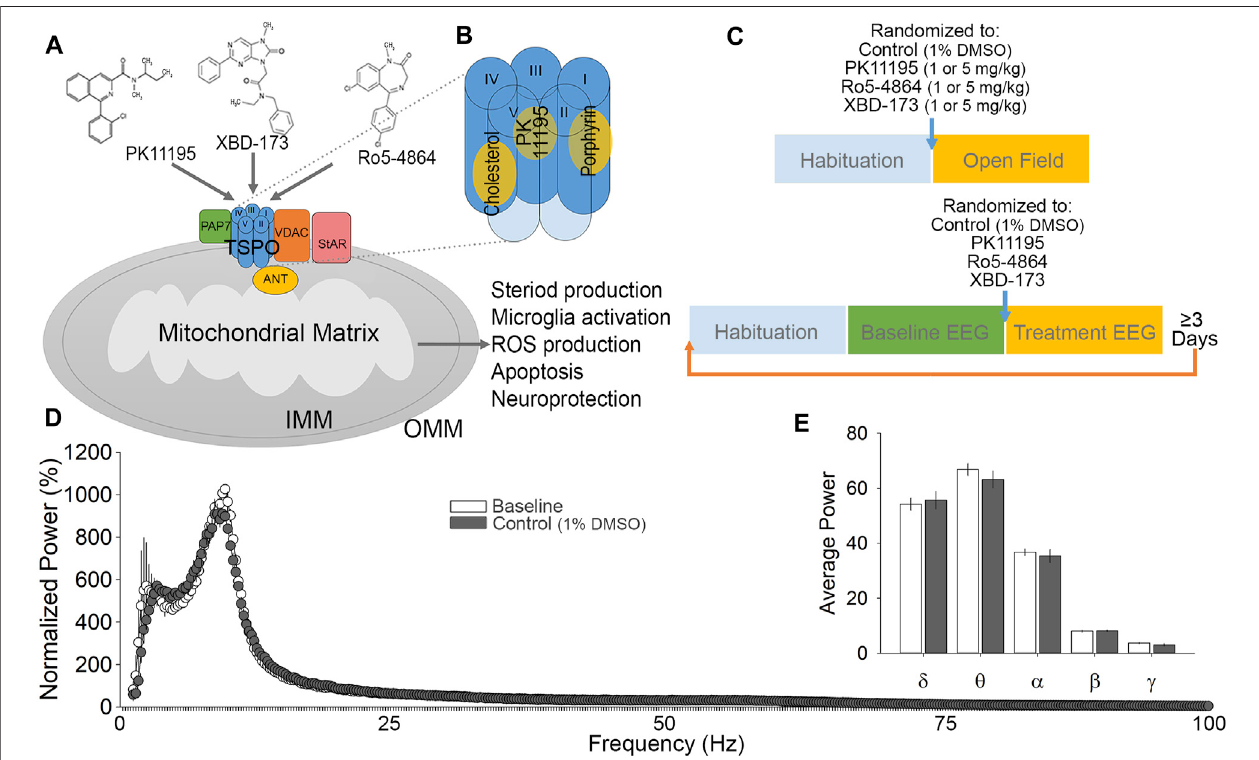
FIGURE 1 | Ligand considerations, experimental design and validation. (A) A diagram of TSPO and associated proteins in the outer mitochondrial membrane. TSPO consists of fi ve transmembrane helices and is associated with voltage-dependent anion channel (VDAC), adenine nucleotide transporter (ANT) and TSPO associatedprotein -7(PAP7). Binding ofPK11195, XBD-173, and Ro5-4864 toTSPOhavebeen demonstratedtoalter multiple cellular functions, primarilywithregards to endocrine signaling and in fl ammation. (B) Proposed binding pockets for TSPO ligands. (C) Experimental timeline for open fi eld test (top) and EEG (bottom) experimentalprotocols.Eachblockrepresents1 hforhabituation(tothetestingroomforopen fi eld;totherecordingchamberandtetherforEEG),andvariousphasesof assessment (open fi eld behavior, baseline EEG, and treatment EEG). (D) Cumulative fast Fourier transform (cFFT) analysis comparing 1-h baseline recording to 1-h following control (1% DMSO vehicle) injection. (E) Spectral analysis comparing baseline to control injection. No signi fi cant difference was detected in any comparison between baseline and control injection EEG recordings.